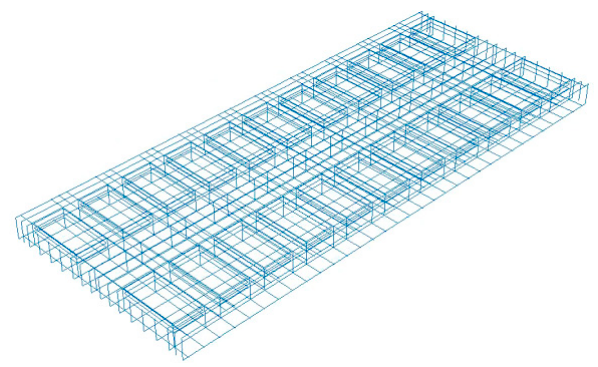
Figure 19. Finite element model of reinforcing bars.